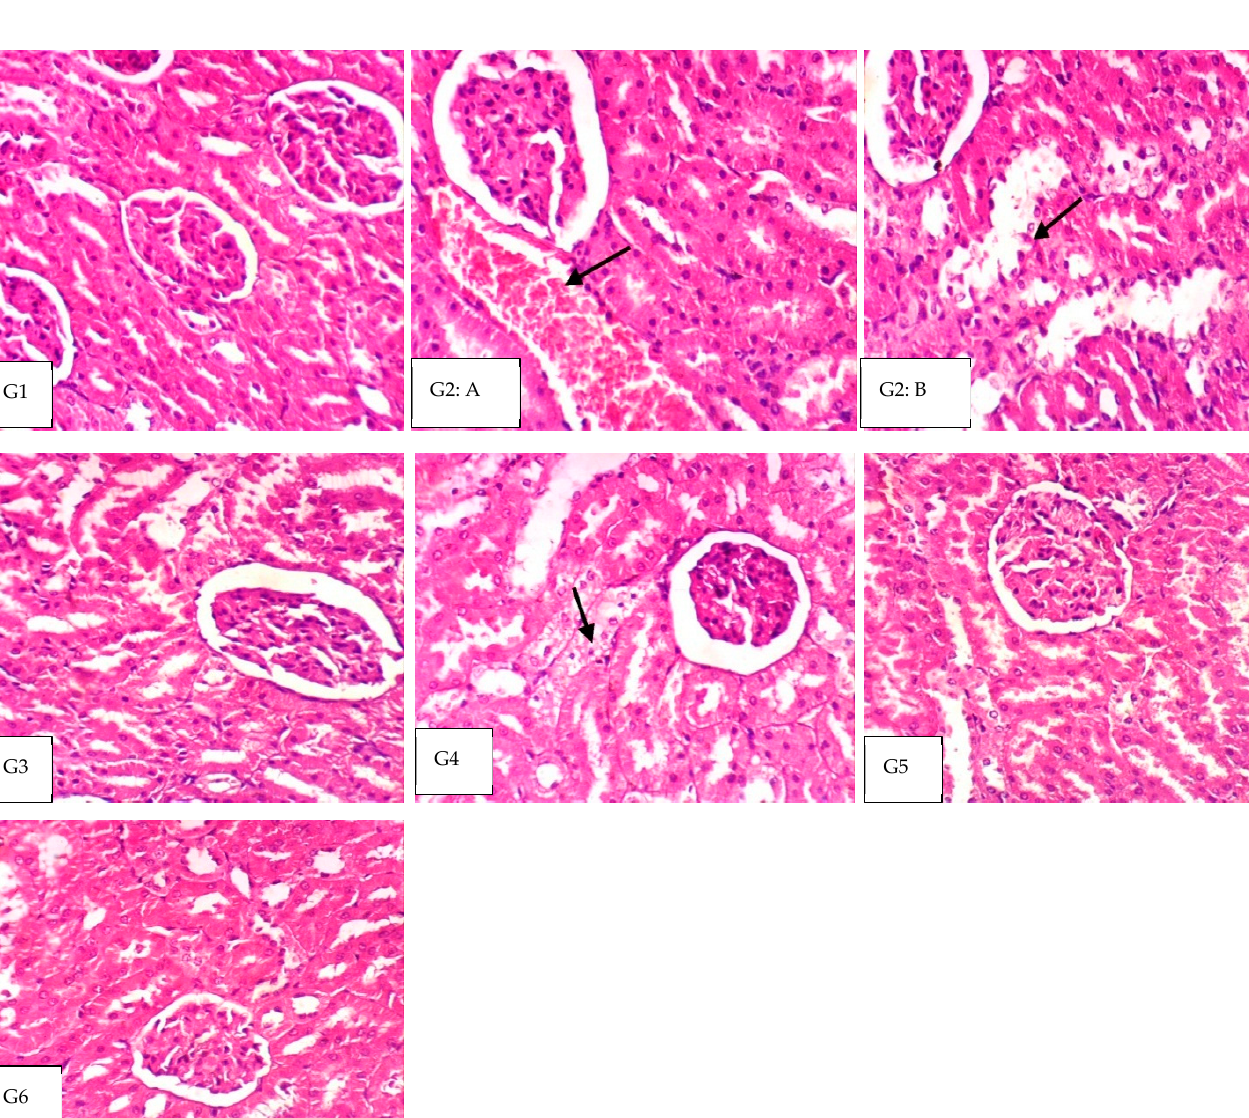
Figure 1. The histopathological kidney evaluation of rat groups; G1 shows the non-obese rats with normal histology of renal tissue (H&E X 400), G2K the obese on regular diet as G2: (A) presenting the congestion of renal blood vessels (H&E X 400) while G2K: (B) showing necrobiosis of the epithelial lining of some renal tubules (H&E X 400). Additionally, G3K of kidney of obese rats on Orlistat supplementation shows no histopathological alterations (H&E X 400). Furthermore, the kidney of obese rats fed on diet 1 is presented by G4K and shows vacuolation of epithelial lining in some renal tubules (H&E X 400). Finally, obese rats’ kidneys on diet 2 G5 and diet 3 showed no histopathological alterations (H&E X 400).